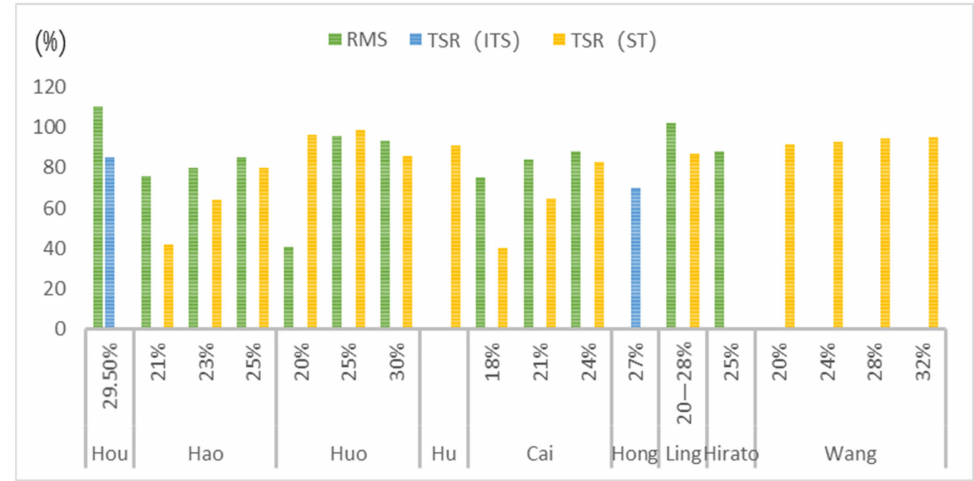
Figure 3. Moisture resistance of